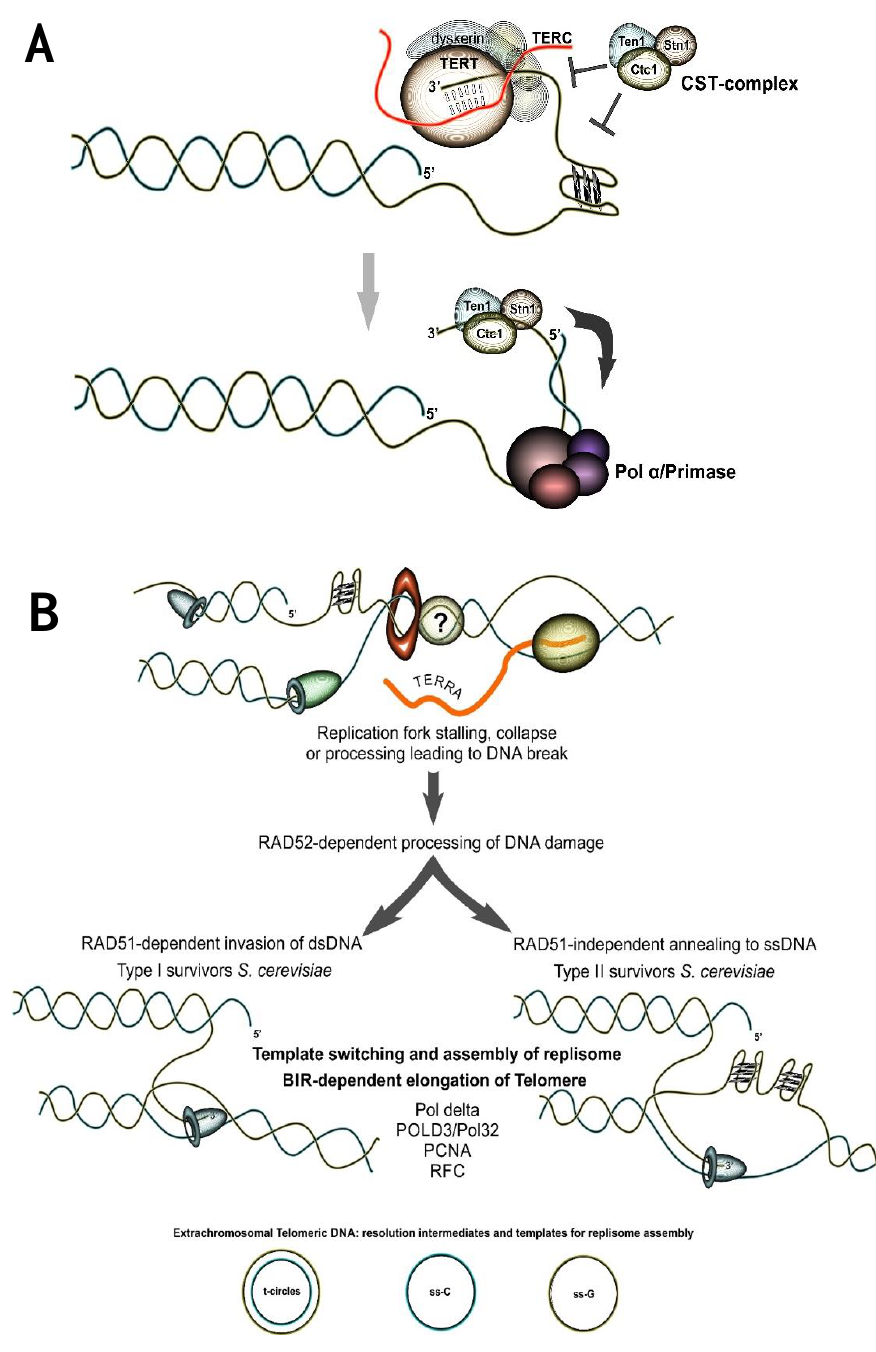
Figure 2. Telomere length maintenance mechanisms. ( A ) A simplified view of telomere length control by telomerase and the CST-complex. Telomerase adds telomeric repeats to the 3’-end of the G-rich